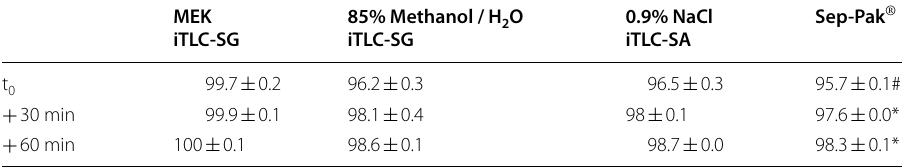
Table 3 Radiochemical purity of [ 99m Tc]Tc-NanoHSA. RCP determined with iTLC and SPE for three individual radiolabellings (n 3) carried out on three consecutive =